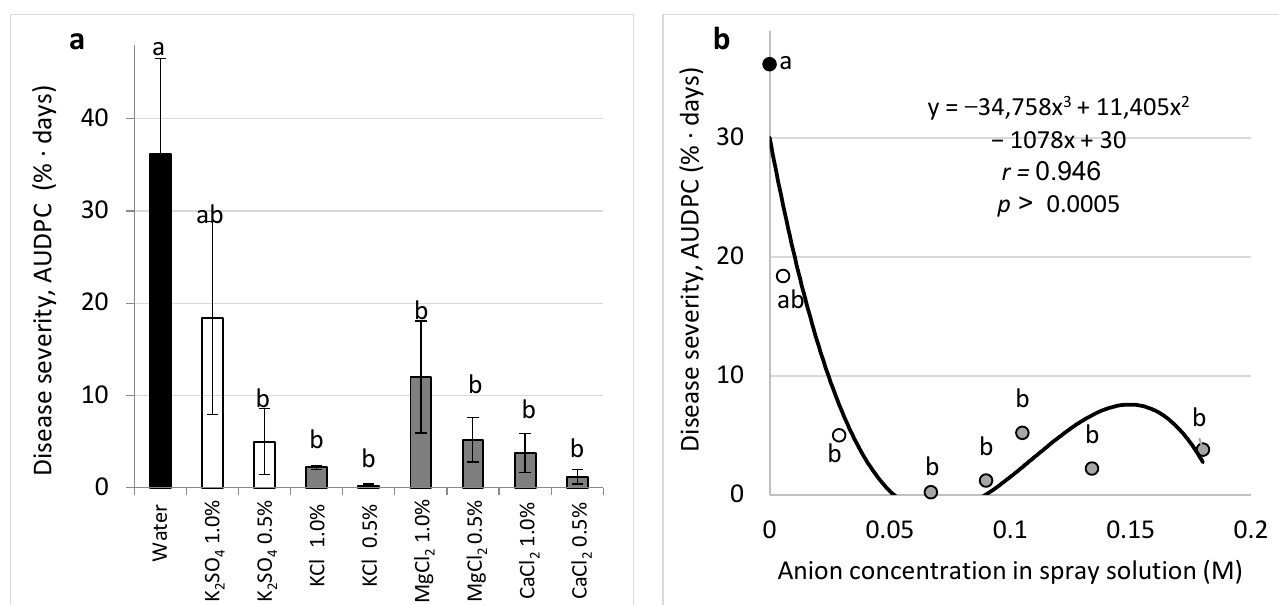
Figure 6. Effect of salts sprays on the severity of cucumber downy mildew (CDM, Pseudoperonospora cubensis ) on cucumber leaves. Sulfate (empty columns and dots) and chloride salts in two equal percentage weight concentrations were applied as sprays on mature plants twice a week. Disease severity is described per salt treatment ( a ) and according to anion concentration ( b ). CDM severity was evaluated on a 0 to 100% scale, where 0% = no disease symptoms and 100% = leaf fully covered by CDM symptoms. Values of the area under the disease progress curve (AUDPC) were calculated for 18 days since disease onset. Values followed by a common letter are significantly not different from each other according to Tukey-Kramer’s HSD test ( p ≤ 0.05). Bars = SE. The regression formula of the drawn trend line is presented, and the correlation Pearson regression value ( r ) is presented along with the significance level ( p ).